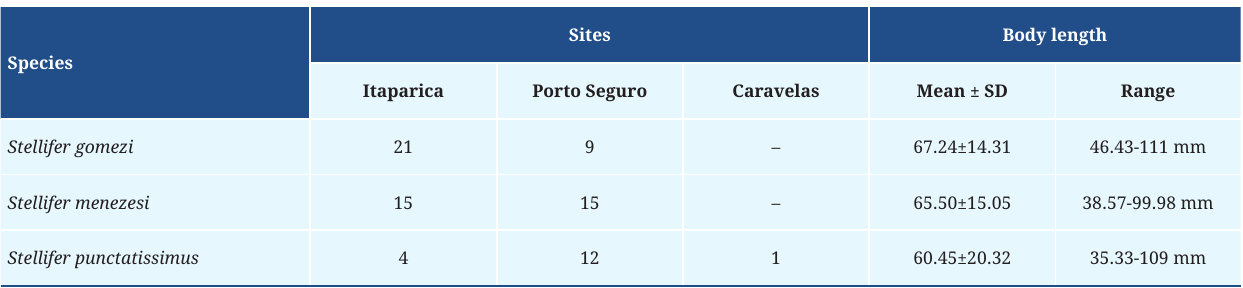
TABLE 1 | The number of specimens analyzed per site, their mean body size (in mm) with standard deviation (SD) and length range by